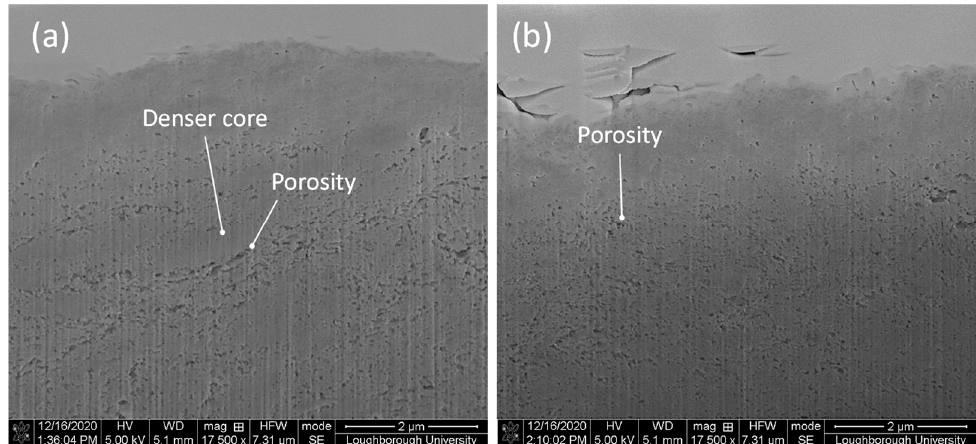
Figure 13. SEM high-resolution images showing a slice milled through the CNT coating: ( a ) denser core and elongated porosity in condition A, ( b ) circular porosity in condition G. All images were taken with a sample tilt of 50°.